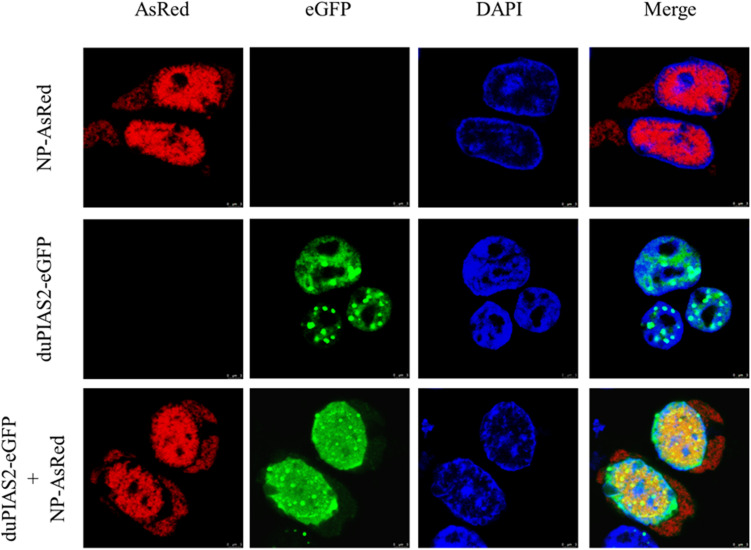
duPIAS2 and DK212 NP were colocalized in transfected cells. HEK 293T cells were cultured on coverslips in 24-well plates until 70% confluence and were transfected with pCAGGS-NP-AsRed and pCAGGS-duPIAS2-eGFP. After 36 h, the transfected cells were fixed with cold methanol, stained with DAPI, and visualized by confocal laser scanning microscope.